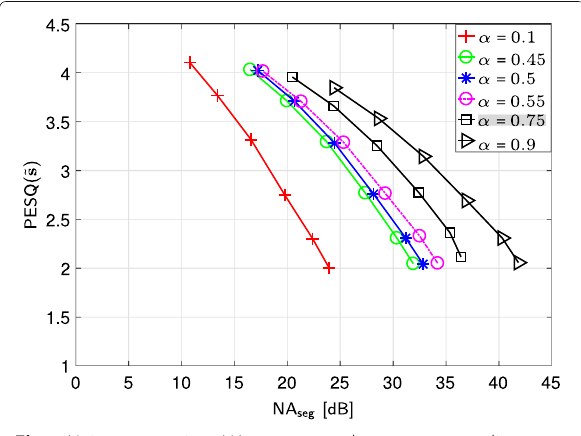
Fig. 6 Noise attenuation NA seg vs. speech component quality Fig. 7 Noise attenuation NA seg vs. speech component quality PESQ s for different parameters and for the new 3CL (11) on PESQ s for different parameters for the baseline eIRM MSE (3) 12 . 5 % of the validation set . From top to bottom, the markers are on 12 . 5 % ofthevalidationset . From top to bottom, the markers are corresponding to six SNR conditions from 20 to 5dB with a step size corresponding to six SNR conditions from 20 to 5dB with a step size of 5dB. The selected setting is gray-shaded in the legend. All curves of 5dB. The selected setting , meaning that the noise attenuation and marked by fulfill 1 2 the speech distortion contribute equally to the 3CL loss (11)